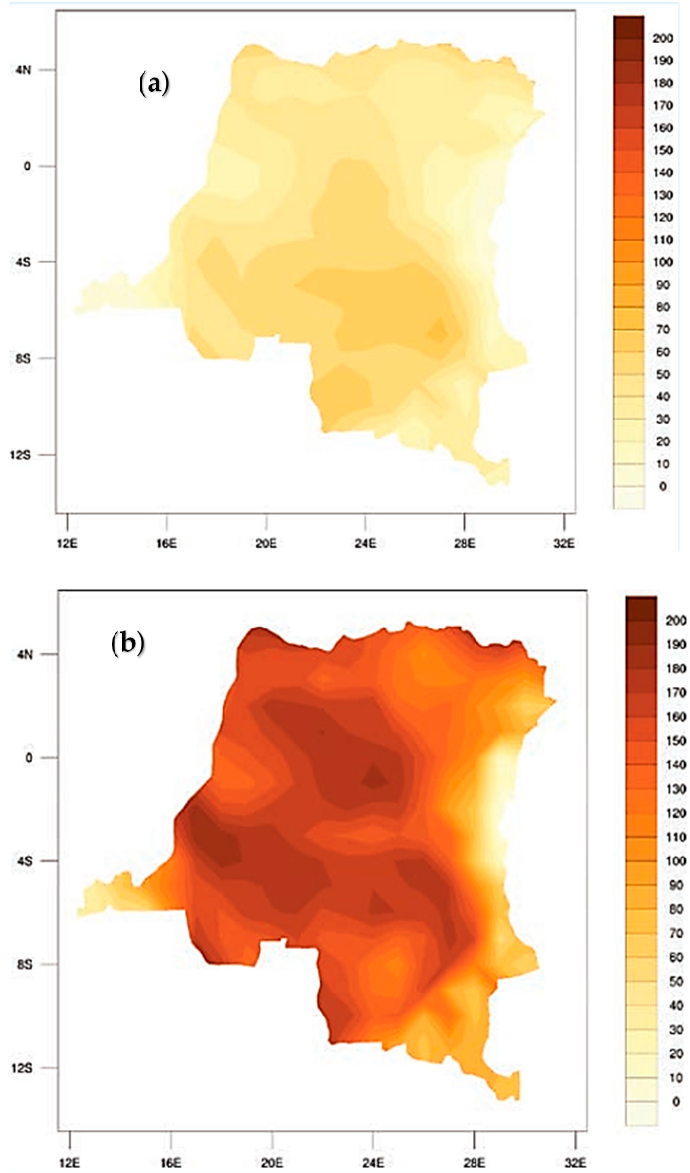
Figure 1. Spatial distribution of changes in the number of heat days (>35 °C) by mid-century (2040– 2059) ( a ) and by end-century (2080–2099) ( b ), as compared to the 1986–2005 baseline, under a high emission (RCP 8 552) scenario.